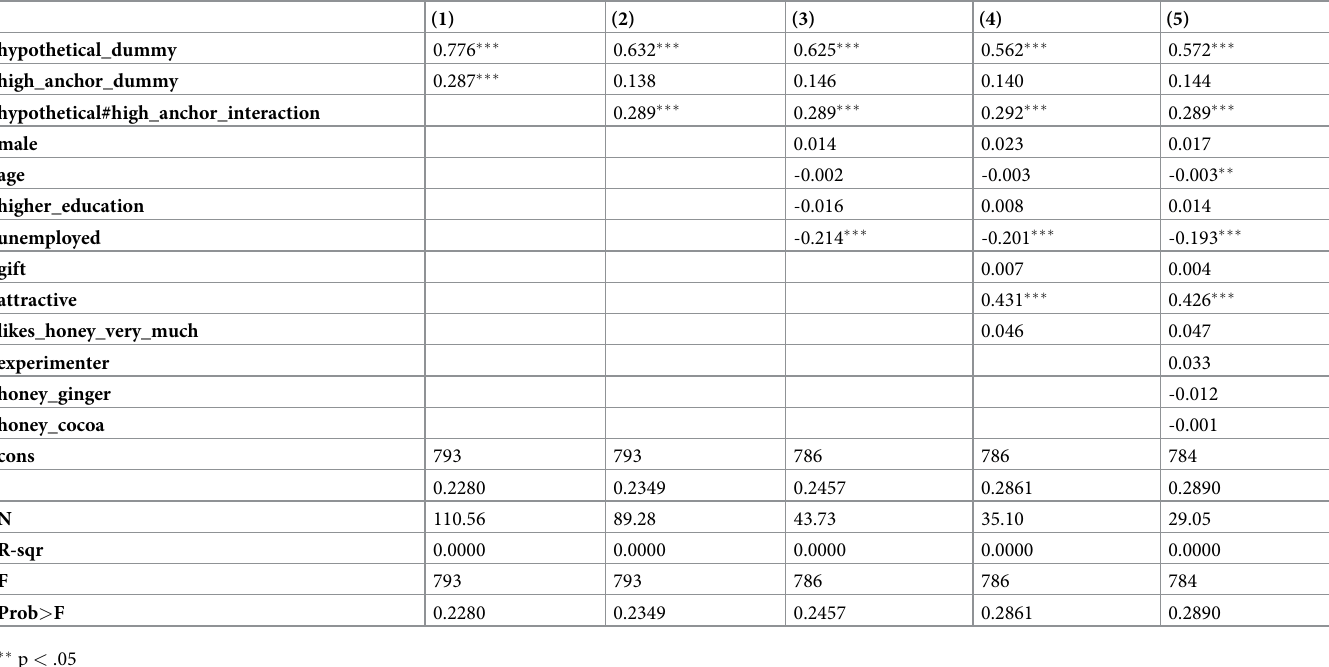
Table 14. Experiment 3: Regression table: WTP values.